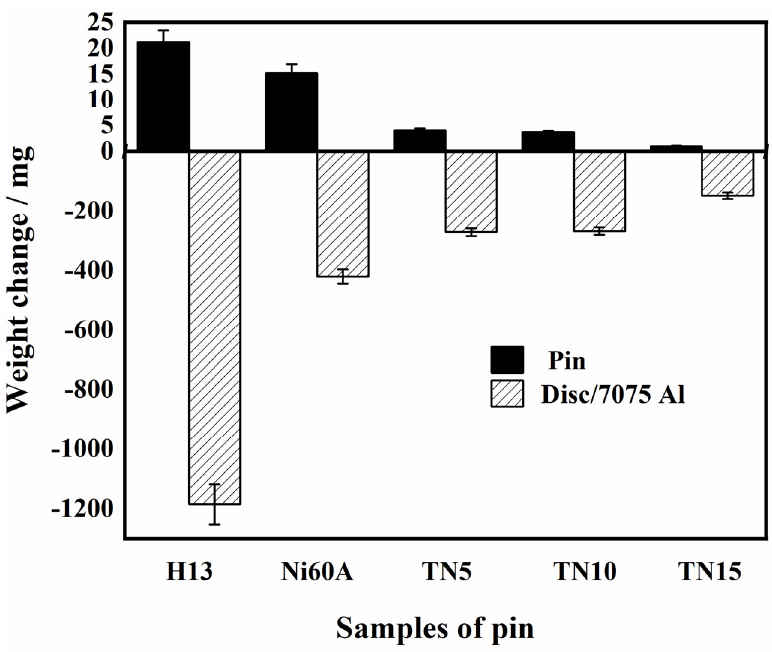
Figure 12. Column showing the weight changes for the disc and pin.